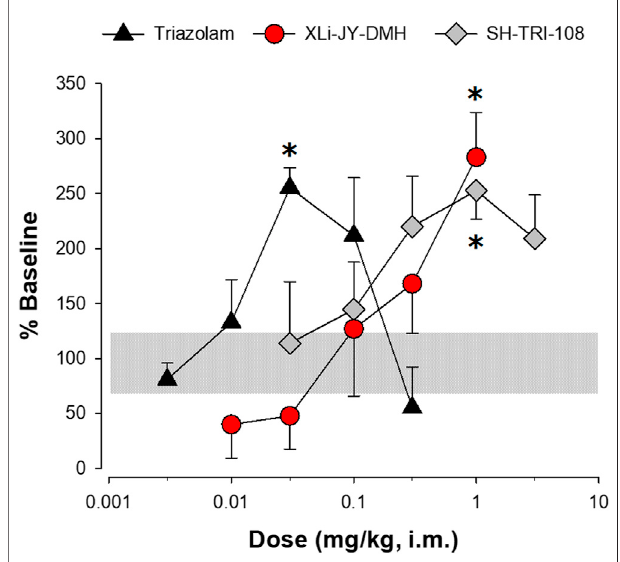
FIGURE 6 | Sucrose pellet consumption by squirrel monkeys (N (cid:1) 4) following i. m. injections of triazolam, XLi-JY-DMH, or SH-TRI-108. Data are percent of baseline pellet consumption, the horizontal gray bar represents lower and upper SEMs for vehicle treatment. * p < 0.05 vs. vehicle, Fisher ’ s method.